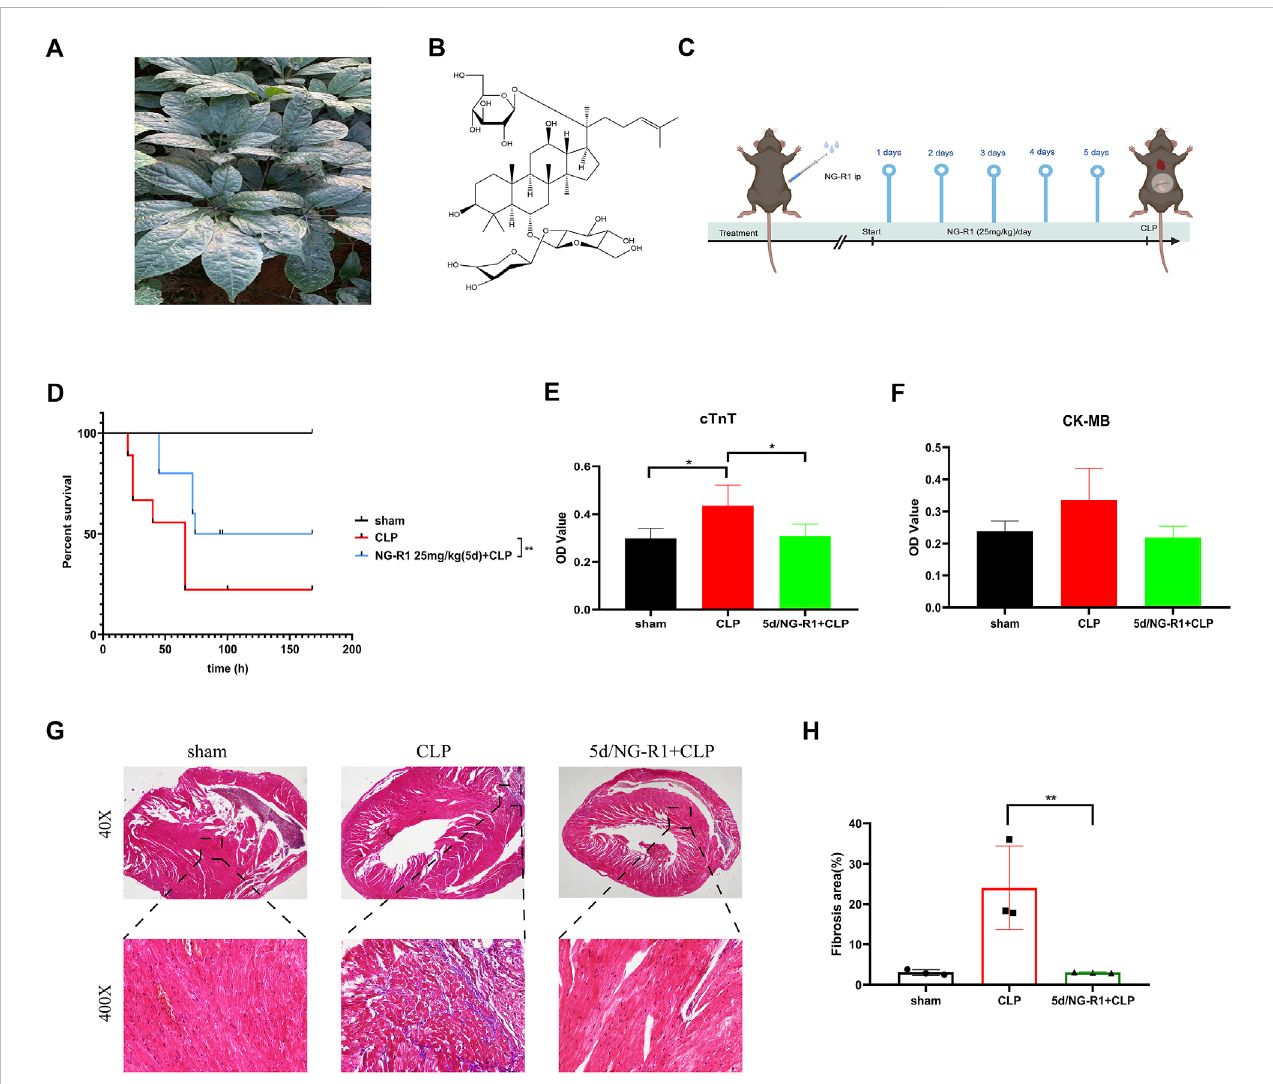
FIGURE 2 NG-R1 increased thesurvival rate and alleviated myocardial injury in sepsis mice. (A, B) Schematic diagram of Panax ginseng plant, chemical structure of Notoginsenoside R1, (C) Flow chart of animal experiments. (D) 7-day survival rates of mice between different subgroups after NG-R1 intervention (n = 10 per group). (E,F) ODvaluesofcTnT,CK-MBinperipheralbloodofmice(ODvaluesareproportionaltoexpression)( n =4pergroup). (G,H) Statisticsofmyocardial tissue masson stainingin different groups (40X) (400X), fi brosis area ( n = 3 per group). The data are represented as means ± SD; * p < 0.05, ** p <